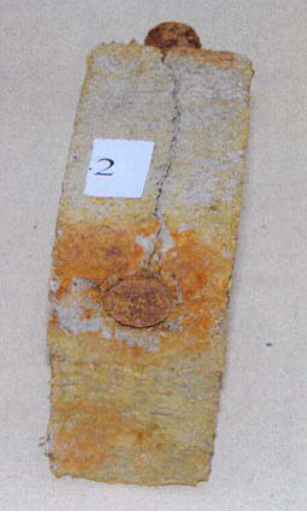
Fig 3. General view of cracking in a